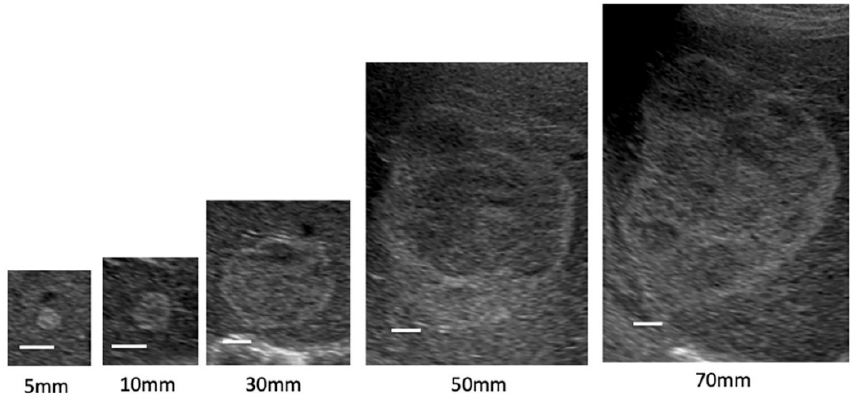
Figure 1. Internal echo pattern according to size of hemangiomas. White bars indicate a length of 10 mm.